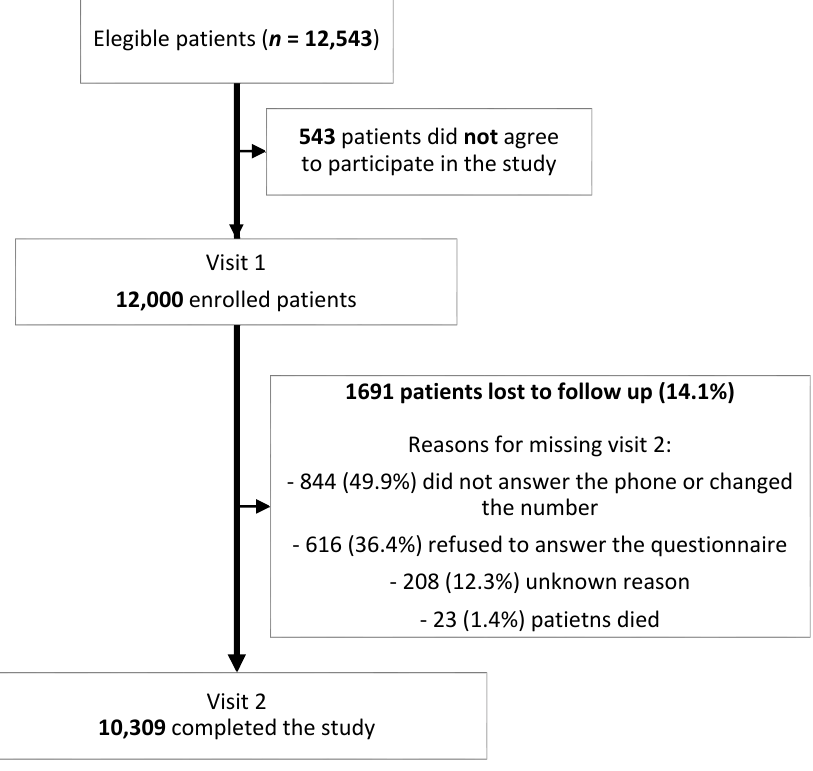
Figure 2. Reason for